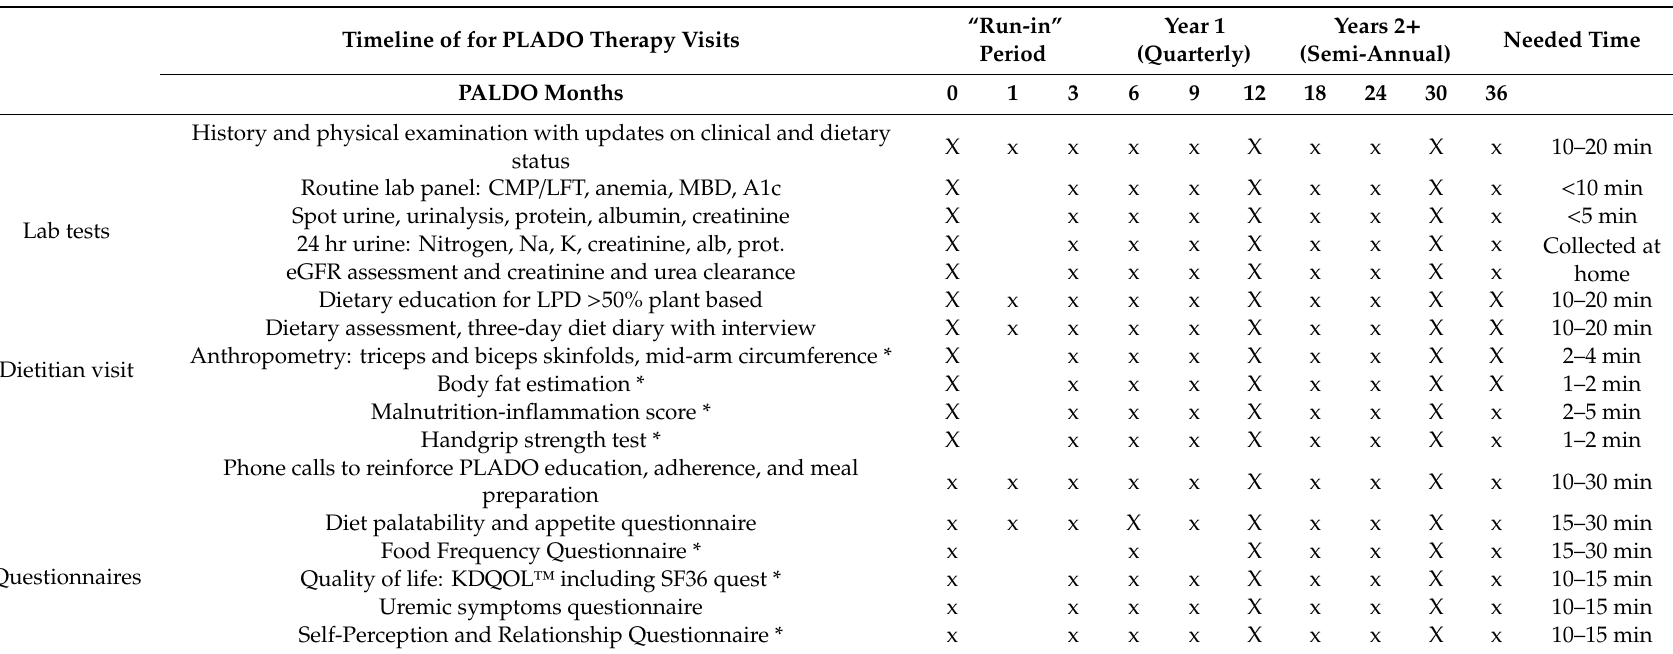
Table 5. Overview of the recommended ambulatory visits and tests under the PLADO regimen (* these items are more relevant to sophisticated centers or under research